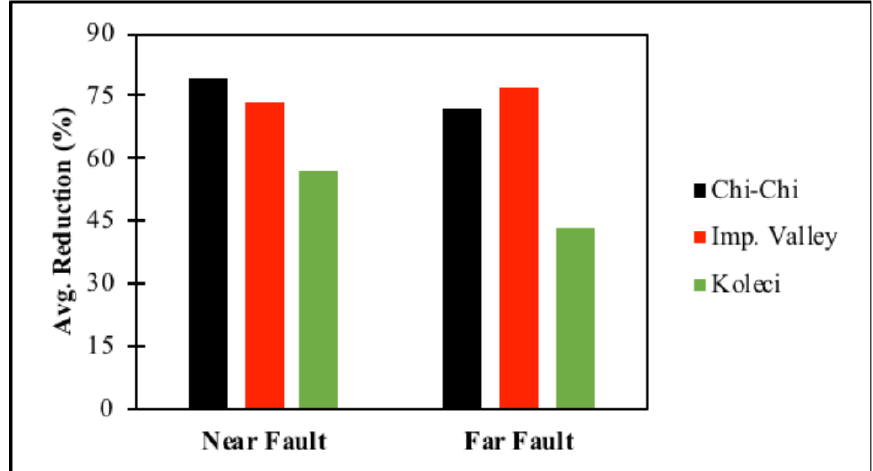
Figure 10. Average displacement response reduction of MRE base-isolated structure (MRE BIS) compared to the passively